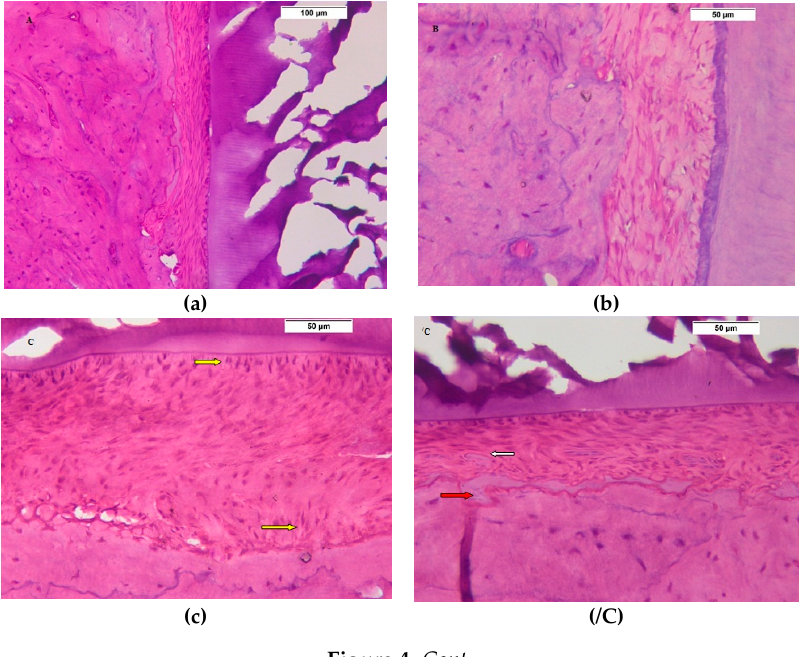
Figure 3. Two week interval. ( a ) Photomicrograph of SRP group showing dilated blood vessels in the periodontal ligament (red arrow) attached to a regular cementum layer, and an irregular bone surface with a layer of osteoid (yellow arrow) (H&E 400×); ( b ) Photomicrograph of ADSC group showing irregularly proliferating periodontal tissue, attached to a regular surface of cementum, and disorganized bone trabeculae showing few cells and many reversal lines (blue arrow) (H&E 400×); ( c ) Photomicrograph of Exo. group shows the interdental periodontal ligament space filled with an organized proliferating periodontal ligament tissue (yellow arrow) (H&E 200×); ( /C ) Photomicrograph showing a periodontal ligament with an organized proliferating periodontal ligament tissue attached to a regular cementum surface with formation of osteoid tissue (blue arrow) (H&E 400×). After the four week interval, in comparison to normal, healthy periodontal tissue of control group (Figure 4a), the SRP group was the least organized one in healing (Figure 4b). The ADSCs showed highly cellular periodontal tissue, with the cells are perpendicular to the cementum and alveolar bone, and the most characteristic finding was multiple blood vessels formation (Figure 4c,/C), while the Exo group showed the most healing signs, represented in periodontal tissues with normal width, well-oriented periodontal cells and fibers (Figure 4d).